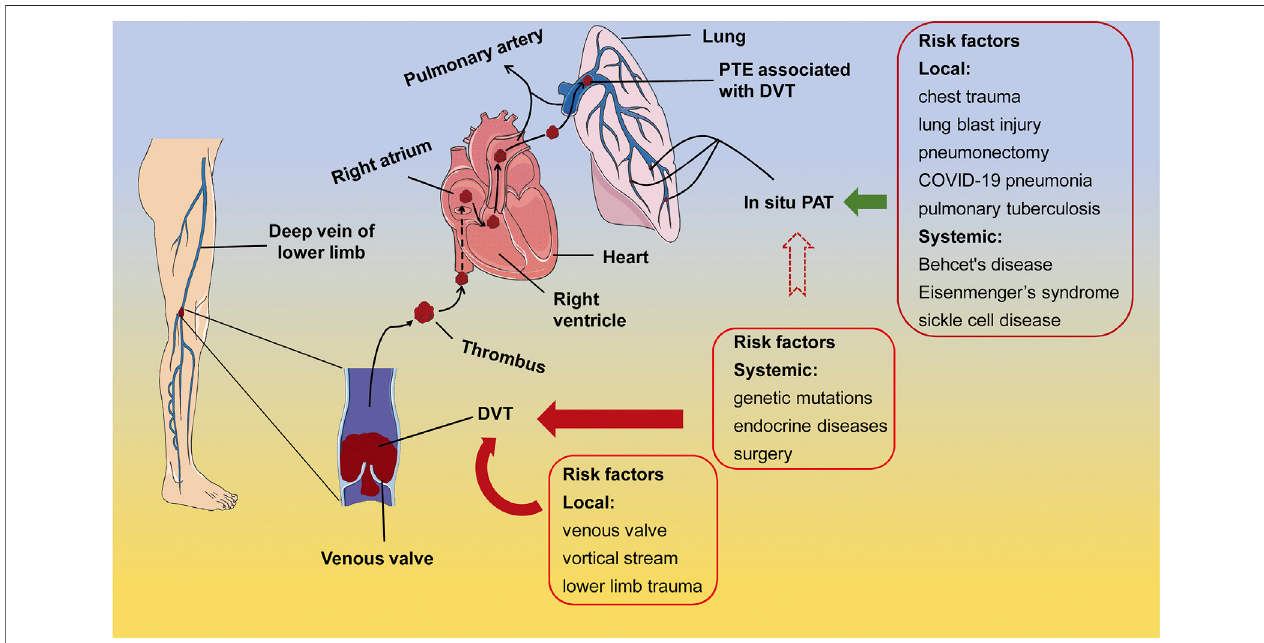
FIGURE 1 | The risk factors of PTE associated with DVT and in situ PAT. In the majority of cases, the systemic susceptible conditions, such as genetic mutations, endocrine disorders, and surgery, as well as the local conditions, such as anatomical and hemodynamic characteristics and trauma, elicit thrombus formation at the venous valves in lower extremities. After shedding from the venous valves, the thrombus travels through circulation to block either the main body or branches of pulmonary artery, leading to the PTE associated with DVT (arrows in dark red). On the other hand, pulmonary diseases, lung damage, and immunological, congenital,and hematologicalsystemic diseasesmaycause insitu PAT(arrowindarkgreen).Itisalsopossiblethat insitu PATisformedunderthesusceptiblesystemic conditionsofDVT,however,directevidenceislacking(arrowindarkreddottedlines).PTE,pulmonarythromboembolism;DVT,deepveinthrombosis; insitu PAT, insitu pulmonary artery